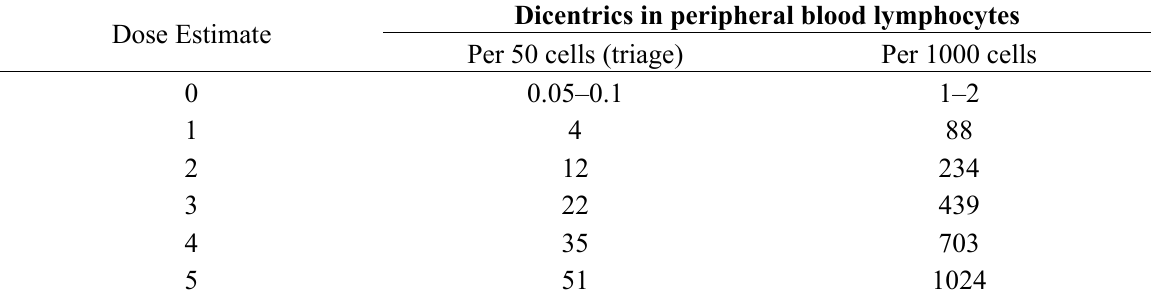
Table 4. Dicentric chromosomes frequency expected in human lymphocytes resulting from different radiation doses